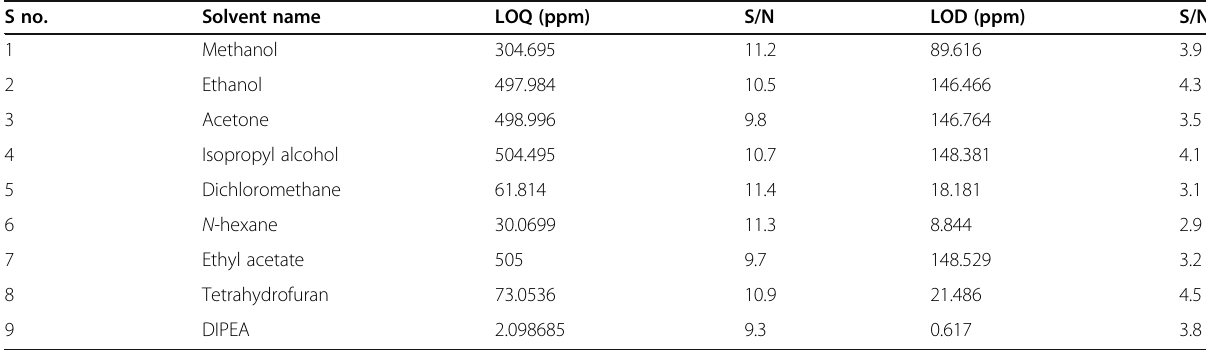
Table 18 Limit of detection and limit of quantitation of each solvent